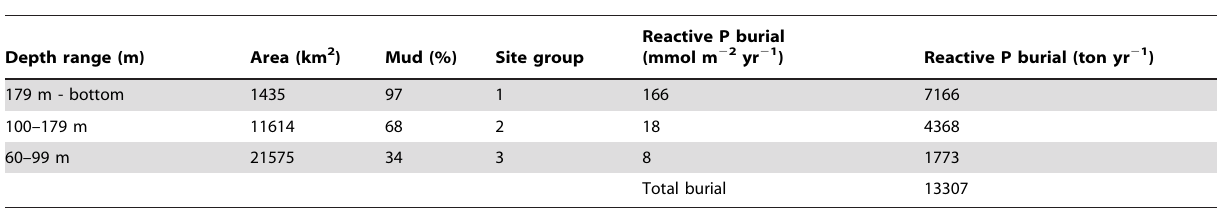
Table 2. Reactive P burial in the Bothnian